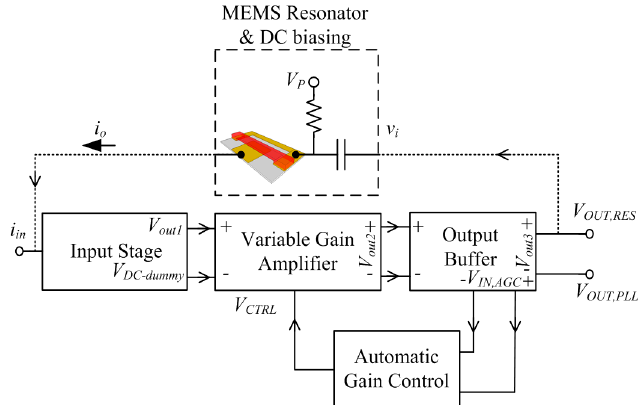
Figure 27 . Typical trans-impedance amplifier (TIA) block diagram, showing a resonator connected in closed-loop.